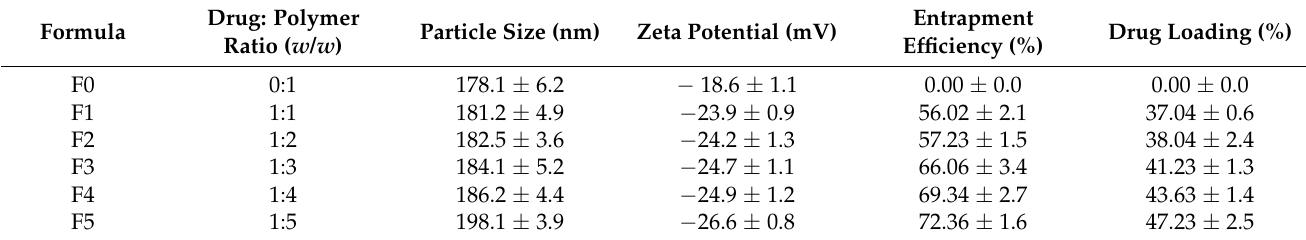
Table 1. Characterization of DXL-loaded SF-NPs prepared at different drug: SF polymer